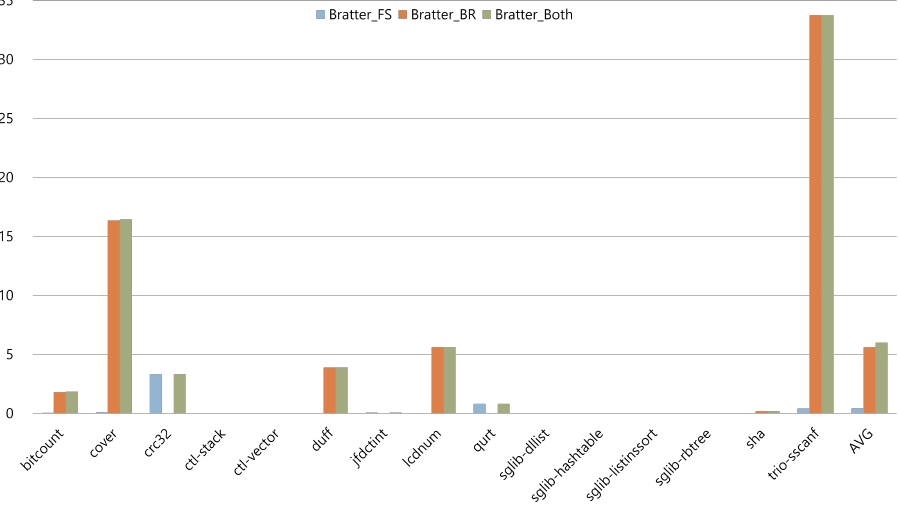
Figure 9. Execution time overhead of the Bratter . Table 2. The number of added and executed instructions table during Bratter